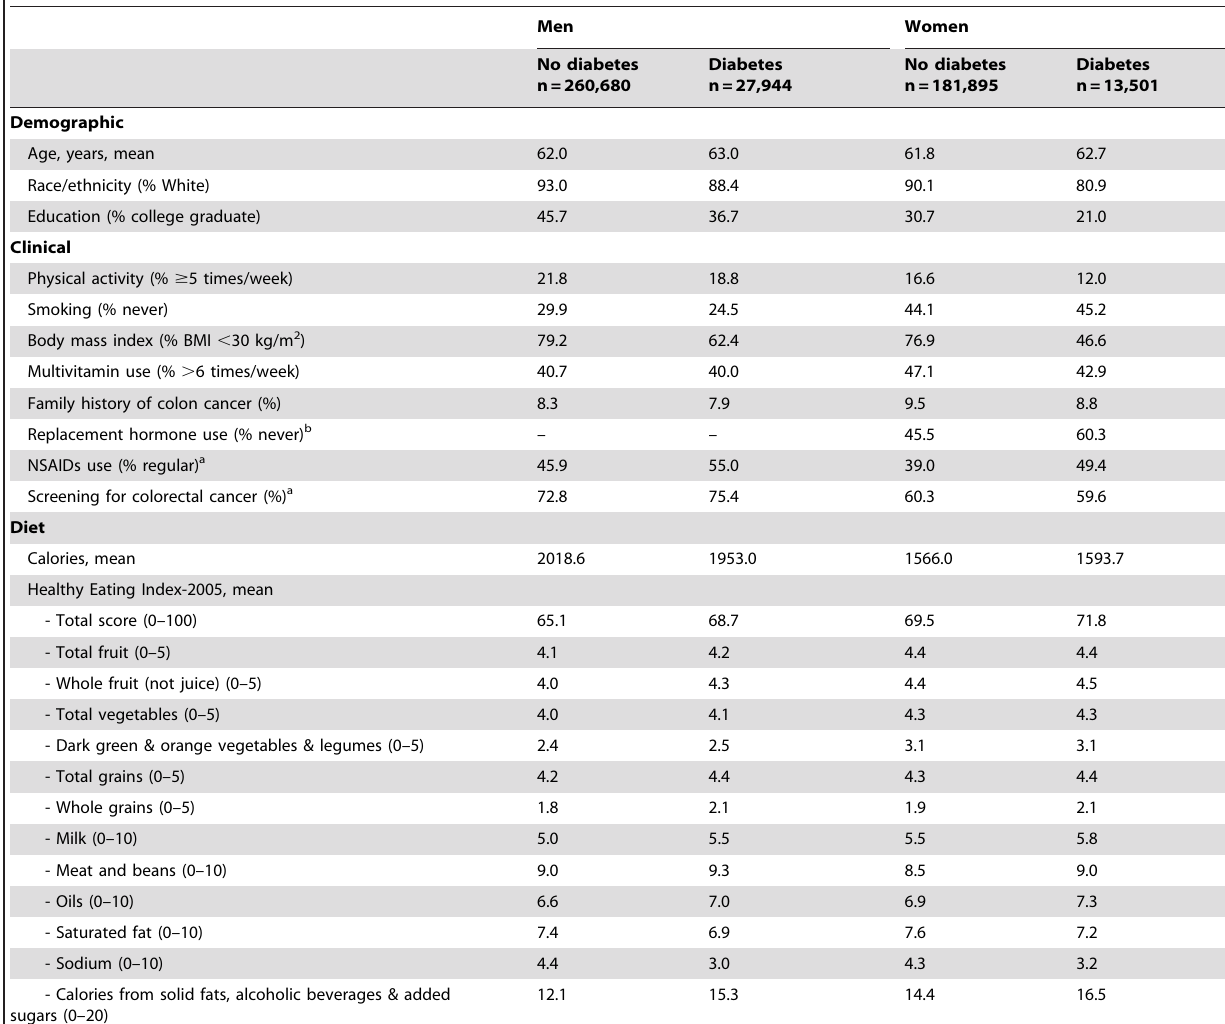
Table 1. Baseline Characteristics of the Study